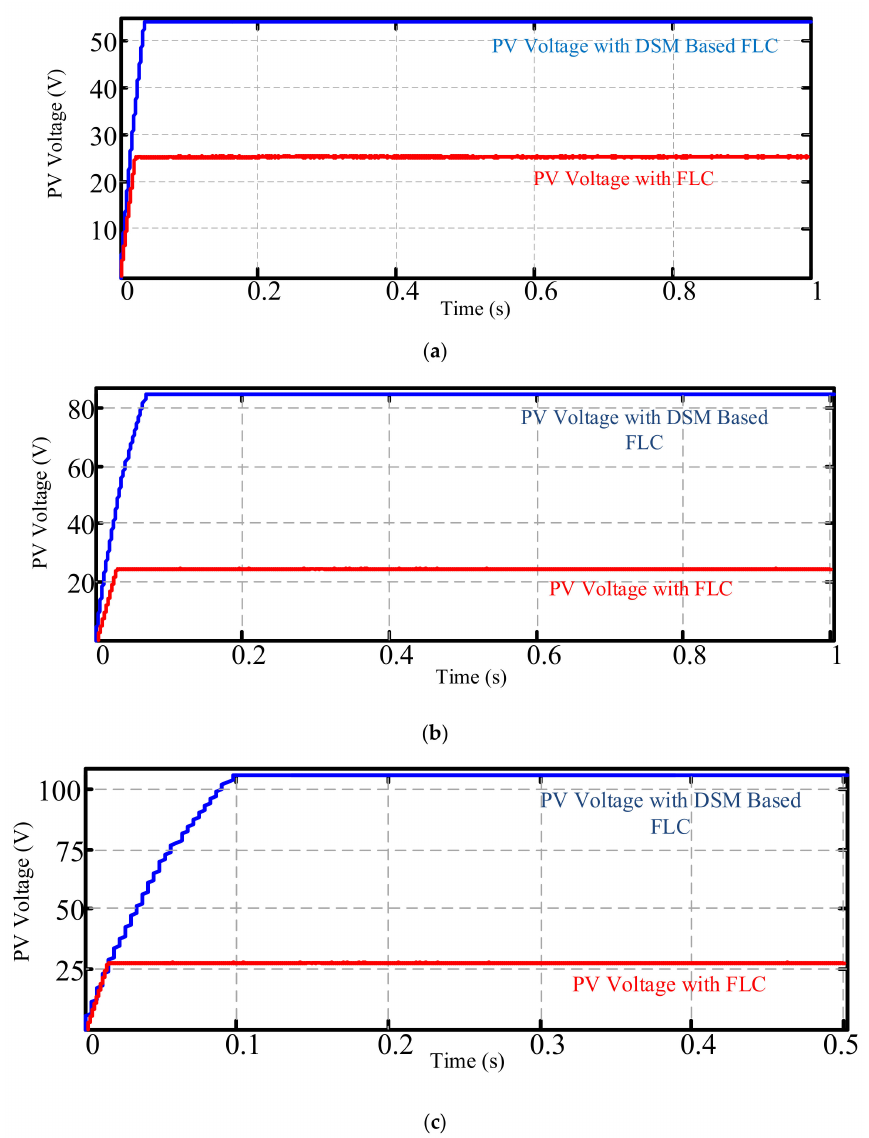
Figure 14. PV voltage for ( a ) one PV module ( b ) two PV modules ( c ) four PV modules at partial shading